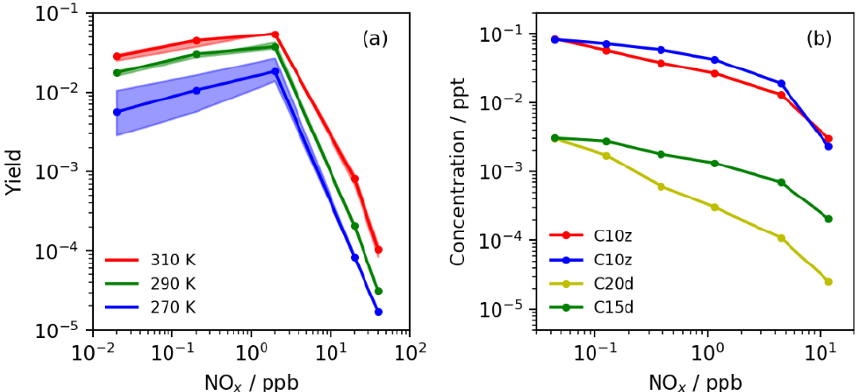
Figure 6. (a) Maximum modelled HOM yields (C10x and C10z) exhibiting significant decline under high-NO x conditions (Simulation C). The spread in the modelled yield between HOM mechanisms (HOM 6000 , HOM 9000 and HOM 12077 ), shown by the shaded regions, indicates the lower sensitivity to autoxidation activation energy at temperatures above ∼ 290K. (b) Observed HOM concentrations from 8d tropical planetary boundary layer (PBL) run (Simulation D) showing decrease in concentration for all HOM species with NO x . Under tropical PBL conditions, a negligible difference was observed between HOM mechanisms due to daytime temperatures exceeding